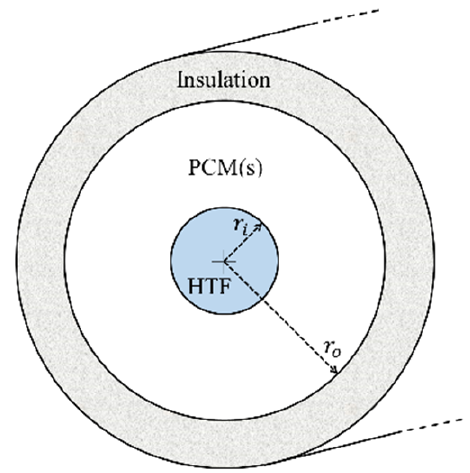
Figure 1. Schematic of the TES unit in the current study. Table 1. Properties of materials employed in this study [26].